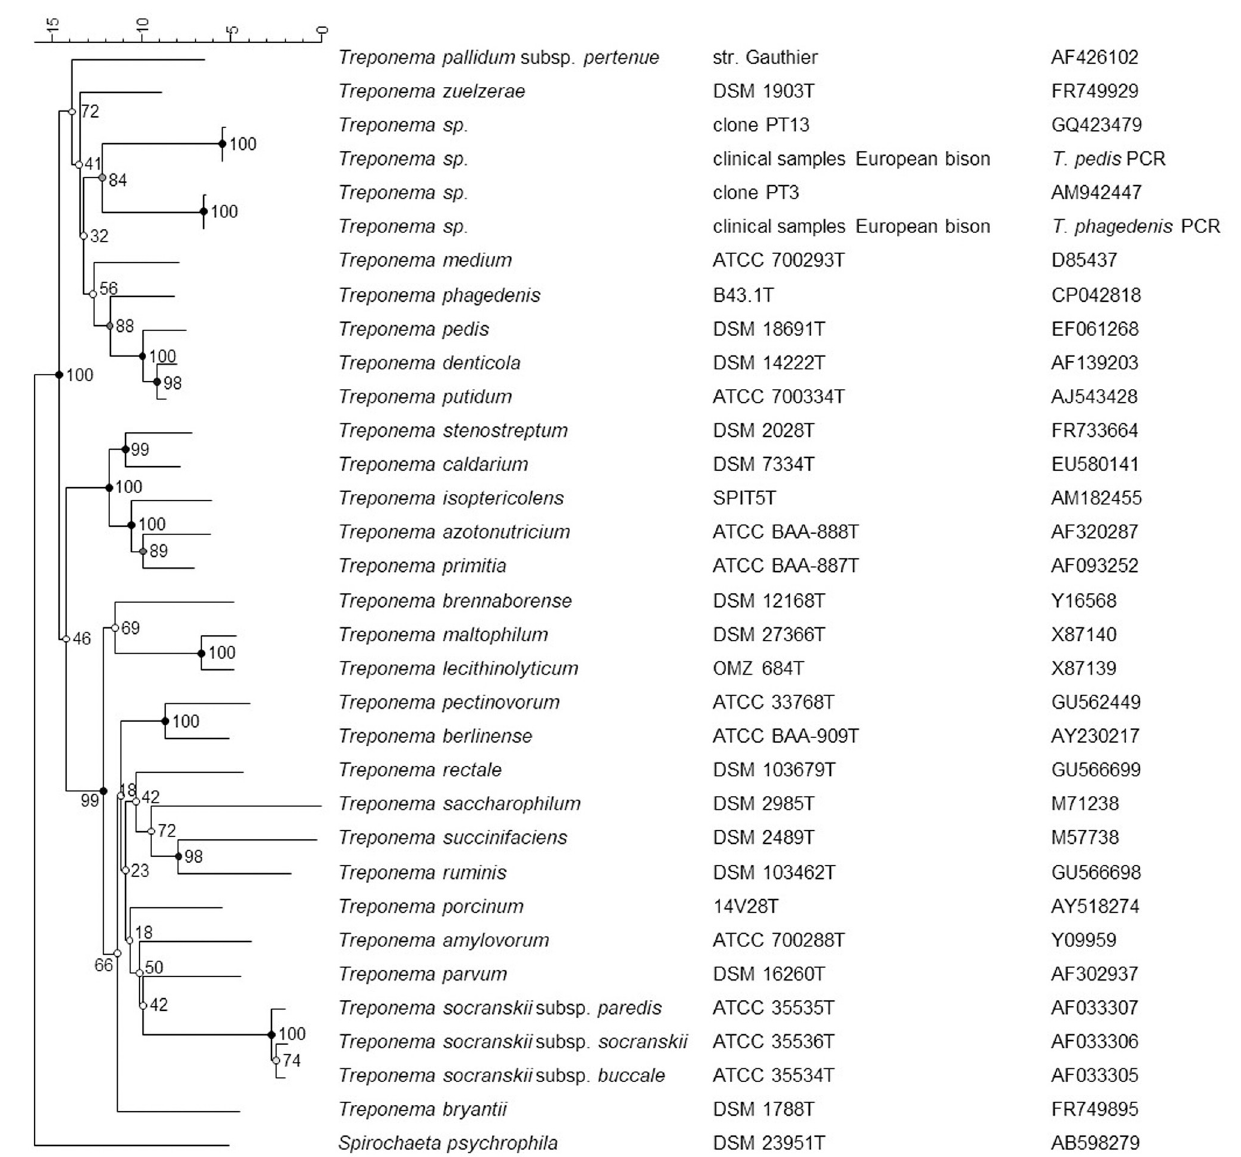
Fig 2. Phylogenetic tree based on partial 16S rRNA gene sequences of currently recognized species of the genus Treponema , the PCR products from clinical samples from lesions of seven European bison ( Bison bonasus ) and the corresponding sequences from GenBank entries of clones PT3 and PT13. Spirochaeta psychrophila was included as an outgroup for rooting the tree that was built in Bionumerics 7.6.3 by using Jukes-Cantor correction and Neighbour joining for cluster analysis. Bootstrap values from 500 iterations are given at branches. The bar represents percent sequence divergence. The species name, strain designation and accession number, where available, is